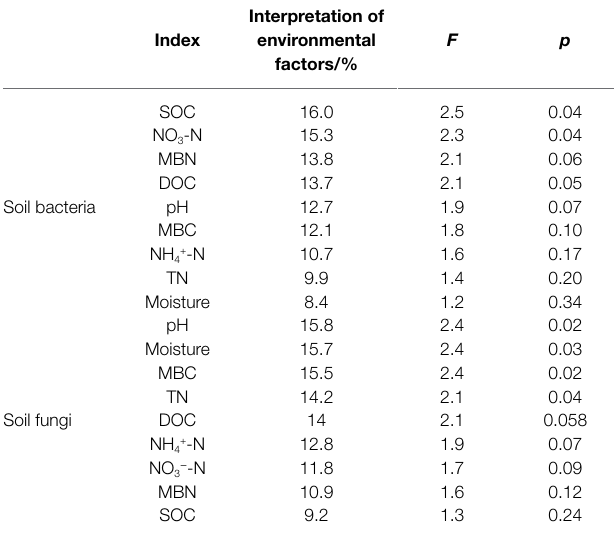
TABLE 1 | Explanatory quantity of soil physicochemical